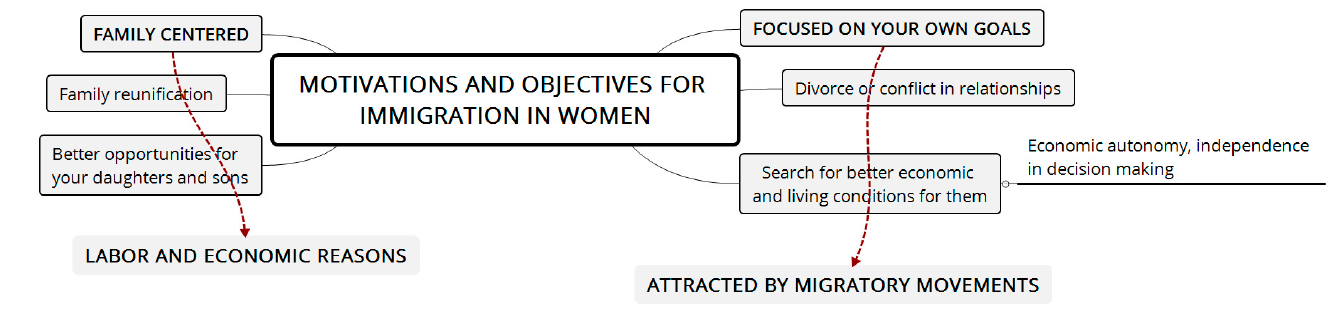
Figure 1. Motivations for the migration of Afro ‐ Colombian women. Source: Own elaboration.